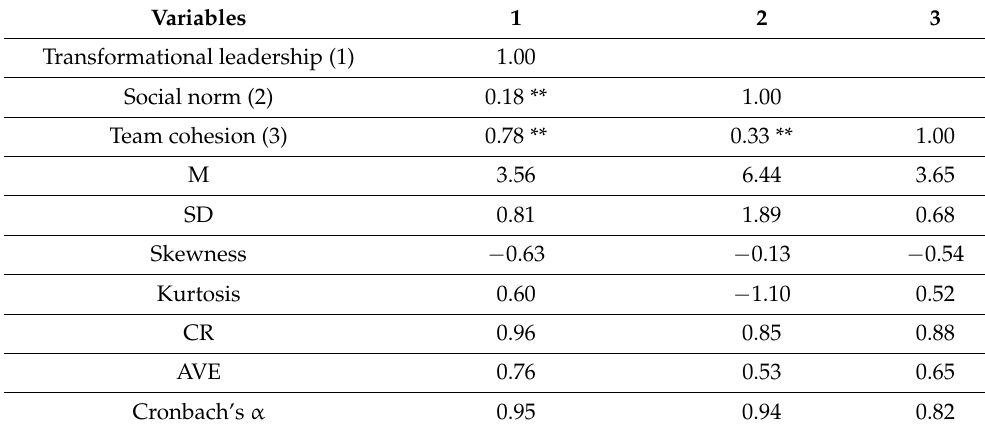
Table 1. Correlation coefficient between measurement variables.